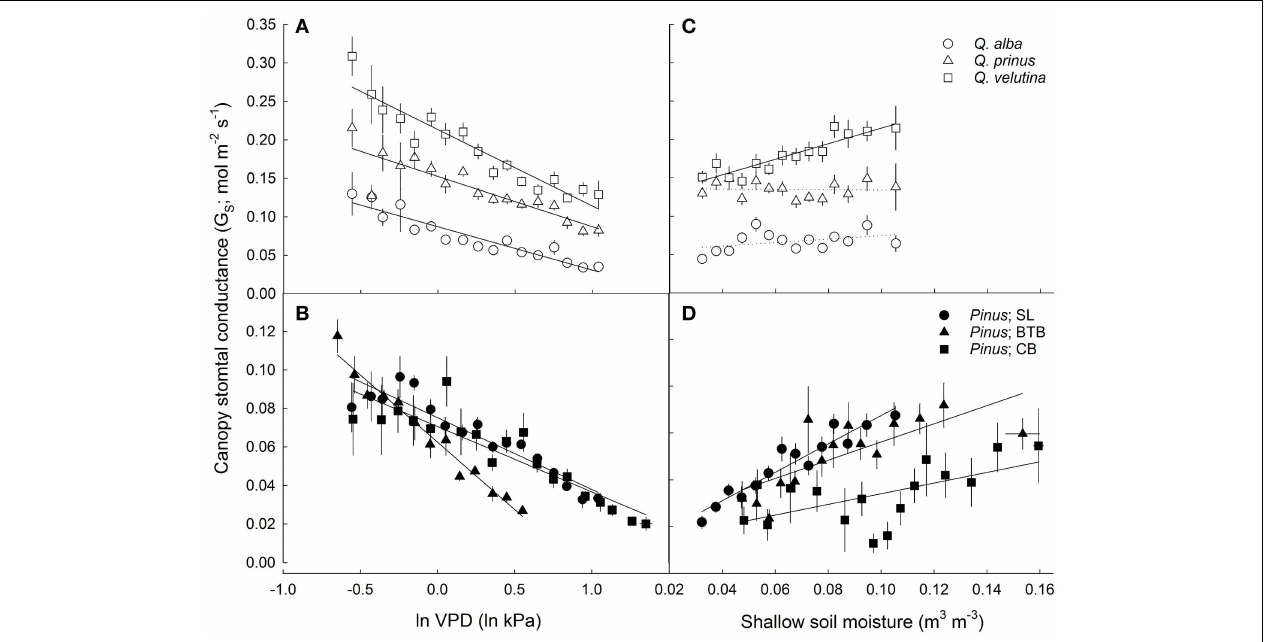
FIGURE 6 | Average daytime canopy stomatal conductance (G S ; mol m − 2 s − 1 ; mean ± SE across all individuals in each site/species category) vs. natural log-transformed average daytime vapor pressure deficit (lnVPD; kPa) for (A) oaks including Q. alba ( y = − 0 . 056 x + 0 . 087 ; r 2 = 0 . 88 ), Q. prinus ( y = − 0 . 065 x + 0 . 15 ; r 2 = 0 . 78 ) and Q. velutina ( y = − 0 . 099 x + 0 . 21